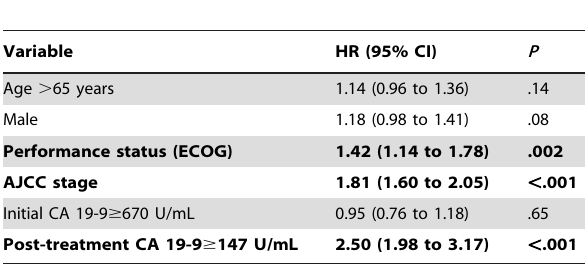
Table 4. Prognostic factors affecting overall survival by multivariate